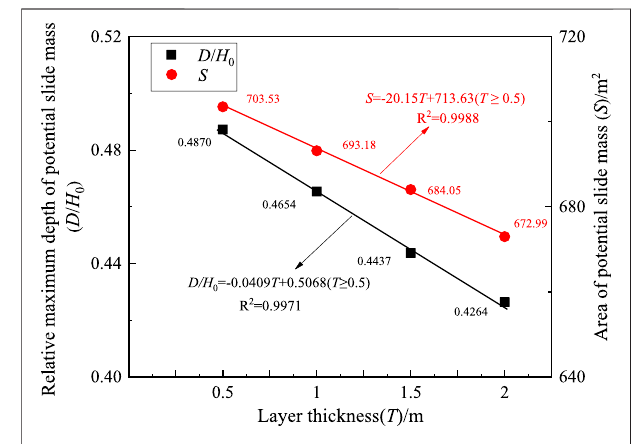
FIGURE 10 | Variations of relative maximum depth and area of potential slide mass with layer thickness at E = 2.0 m/day.